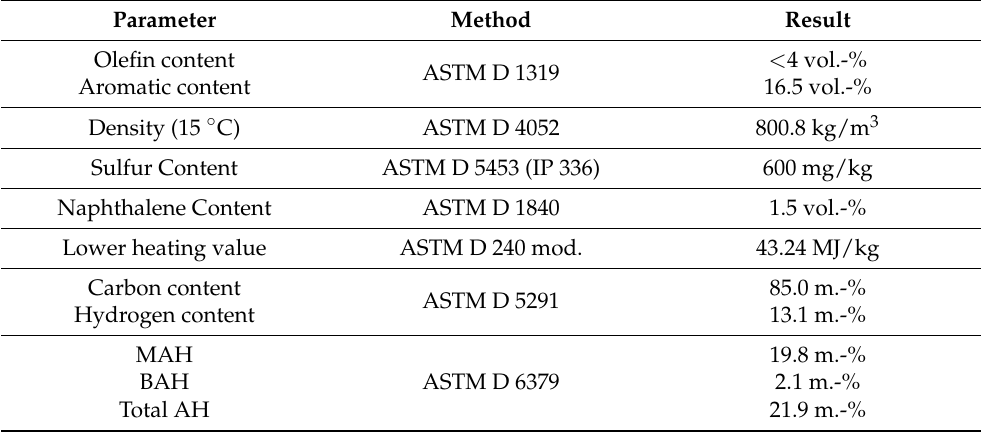
Table 2. Properties of the used